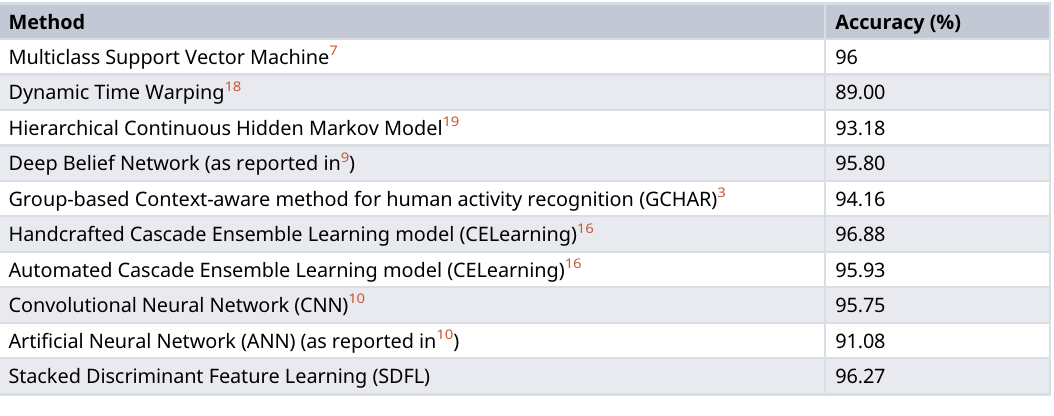
Table 3. Performance comparison of Stacked Discriminant Feature Learning (SDFL) with alternative